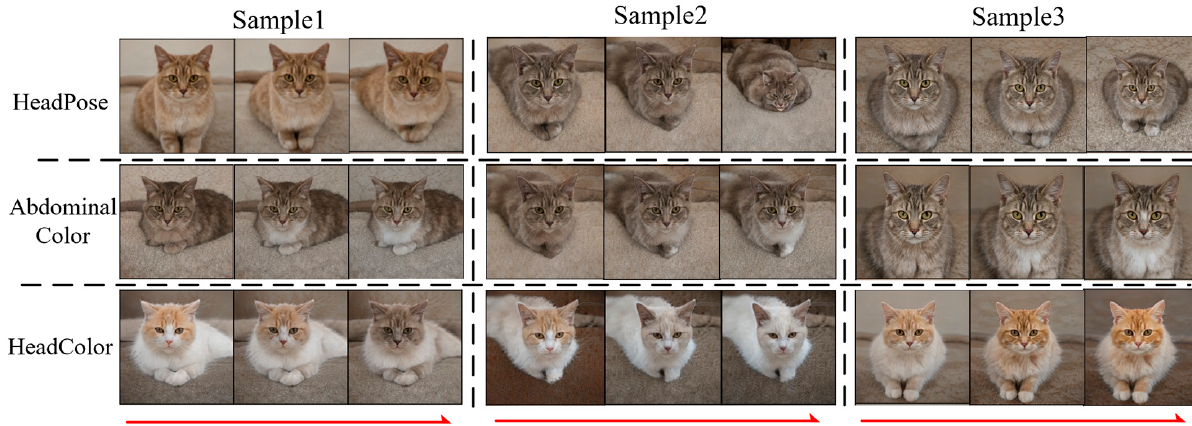
Figure 15. Local Jacobi disentangled method editing results for the LSUNCat dataset.